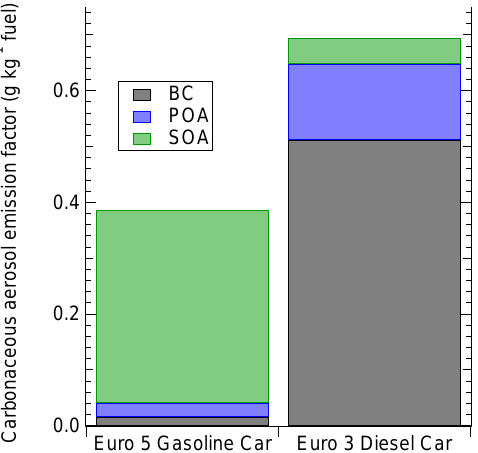
Fig. 8. Primary aerosol emission factors and secondary organic aerosol formation factors calculated for the Euro 5 gasoline light- duty vehicle (GLDV) (average over experiments 1 and 2) of this study and the results of a previous smog chamber study on a Euro 3 diesel passenger car (with oxidation catalyst, but without diesel particle filter, DPF) by Chirico et al. (2010). The diesel emissions are dominated by black carbon (BC, black) and primary organic aerosol (POA, blue) with only a small secondary organic aerosol (SOA, green) fraction. Conversely, a large fraction of the GLDV emission comprises SOA after aging. The large SOA fraction for the GLDV suggests a larger contribution from gasoline vehicles to ambient particulate pollution than has so far been recognised based on primary emissions. Further, future use of DPFs would remove al- most all of the primary BC and POA emissions from diesel vehicle emissions, in which case the total particulate emissions (i.e. POA + SOA) for the GLDV may exceed those of a diesel vehicle. It should be noted that smog chamber OA concentrations in the Chirico et al. (2010) study were lower ( < 30µgm − 3 ) than those in this study, leading to lower emission factors due to lower partitioning to the aerosol